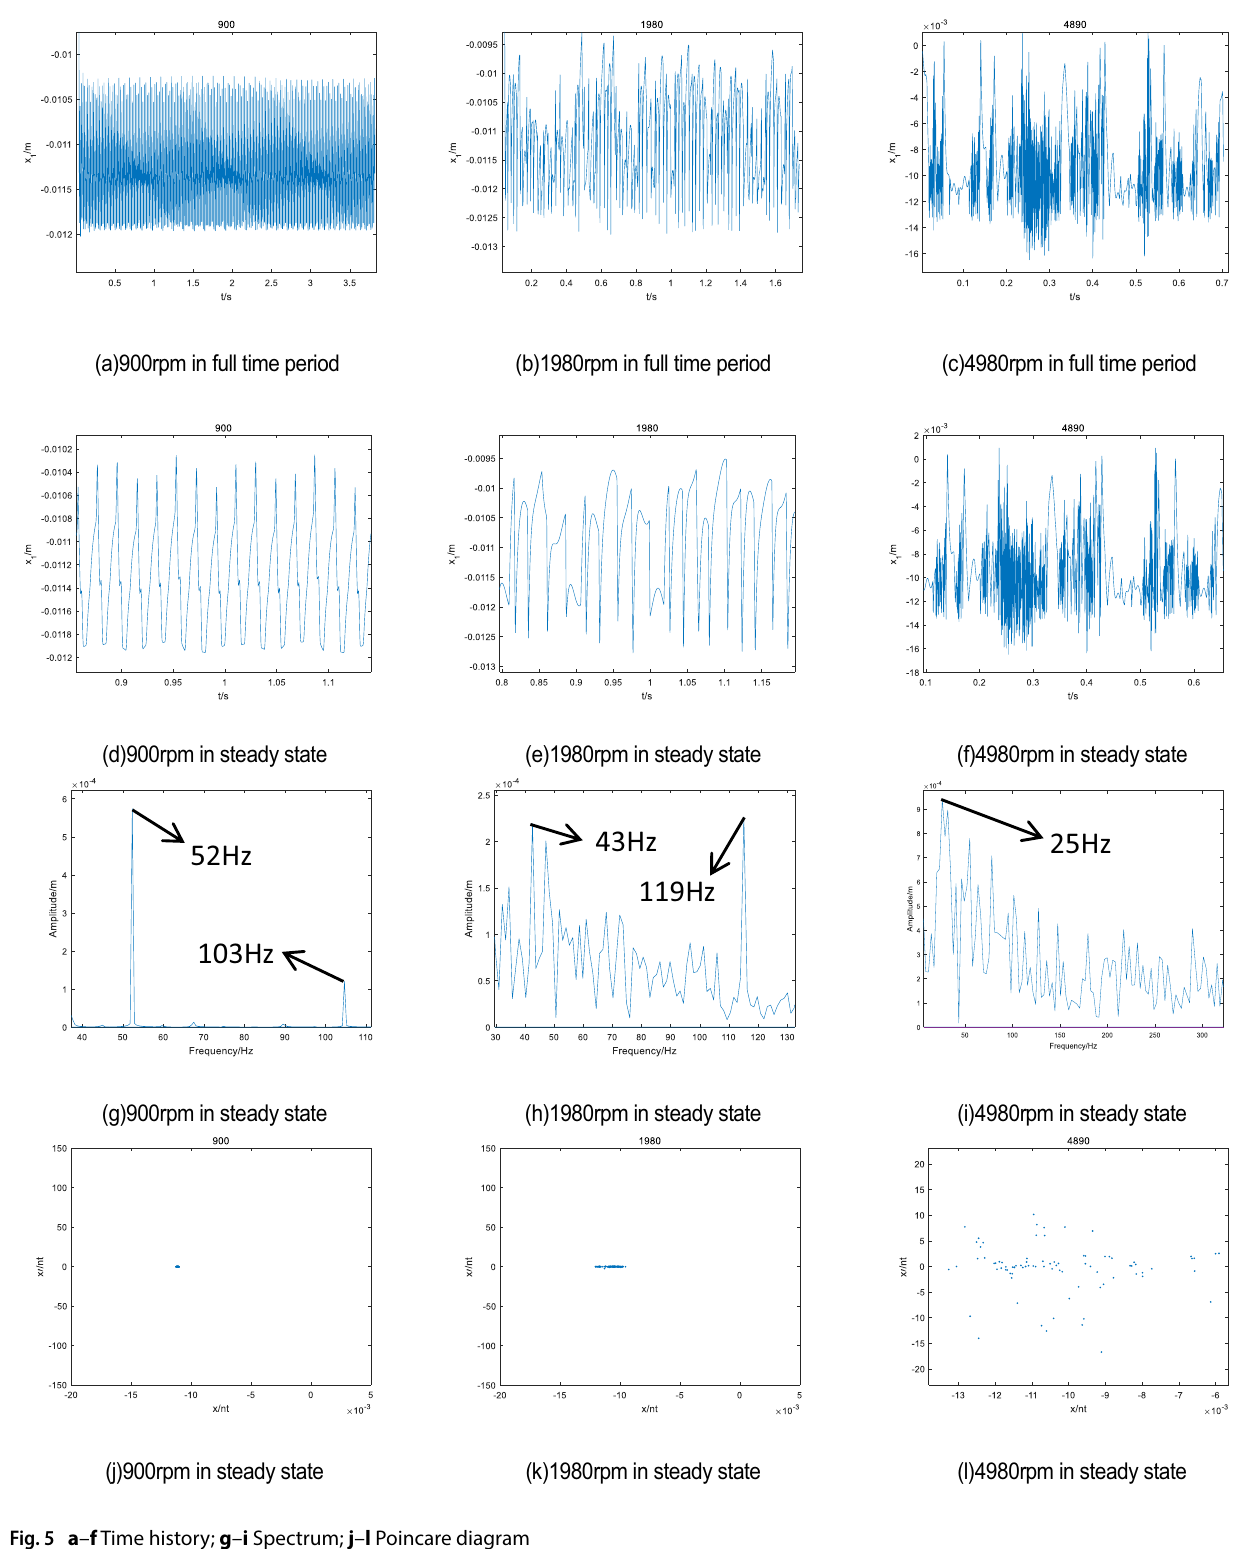
Fig. 5 a – f Time history; g – i Spectrum; j – l Poincare